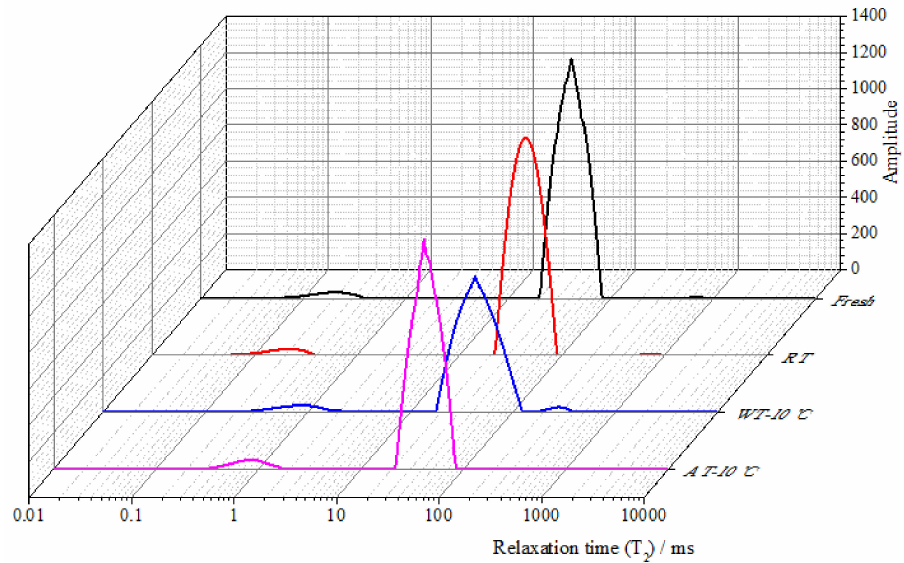
Figure 6. Transverse relaxation time ( T 2 ) curves of salmon samples after tempering, evaluated by LF-MNR. (RT: Radio frequency tempering; WT + 10 ◦ C: Water tempering at 10 ± 0.5 ◦ C; AT + 10 ◦ C: Air tempering at 10 ± 1 ◦